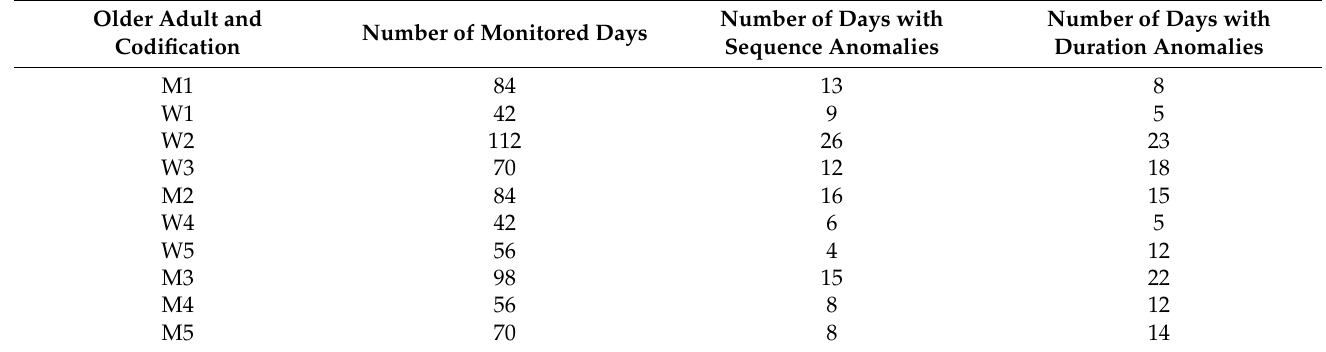
Table 3. ADLS data used in experiments.